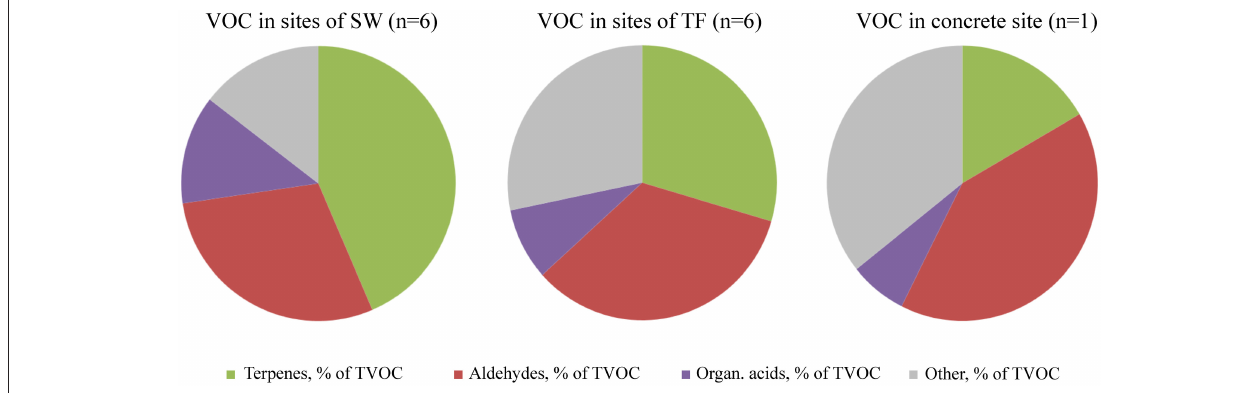
FIGURE 3 | Average TVOC-composition in dependence of the construction type.